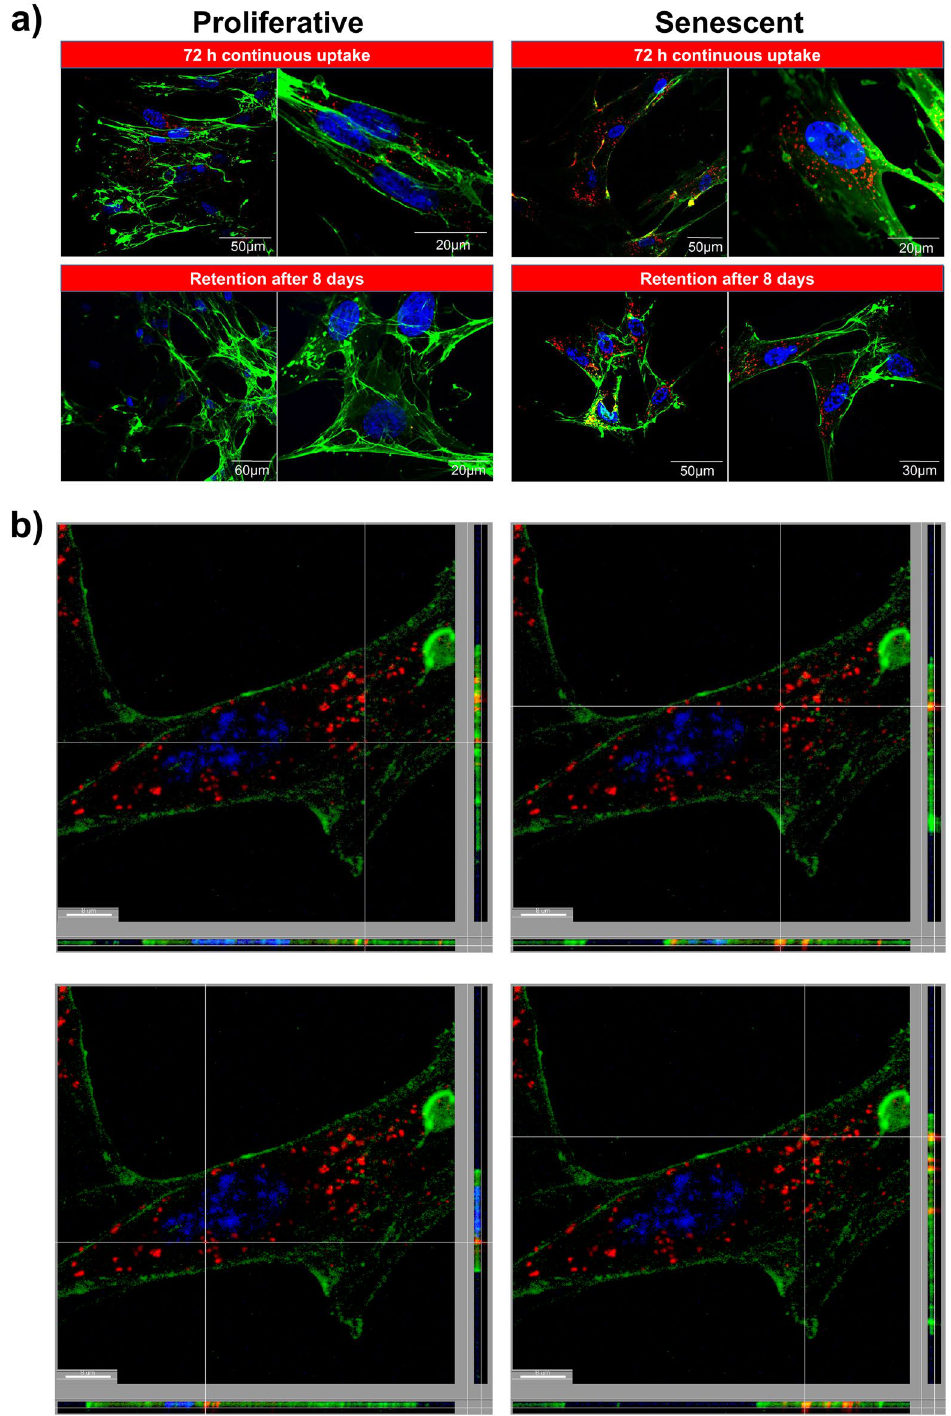
Figure 3. In depth analysis for the uptake and retention of 200 nm SiNPs. ( a ) CLSM images showing the comparison of proliferative and senescent cells with 72 h of continuous uptake and retention after 8 days. ( b ) Z-stack slice of senescent cell with SiNP retention after 8 days. The images show four different focus points within the same cell. The region of interest on each image is set where the lines intersect and the x–z and y–z axis are shown along the side of each x–y slice. ( a , b ) Staining with Hoechst 33342 (blue) and conconavalin A (green) shows the nucleus and cell membranes, respectively, in relation to SiNPs